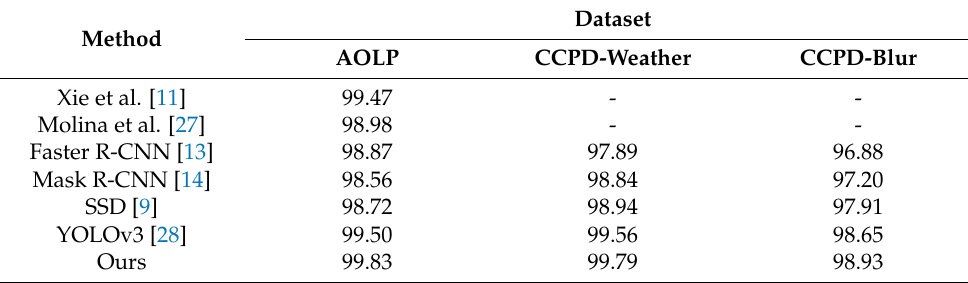
Table 6. F-measure on AOLP, CCPD-Weather and